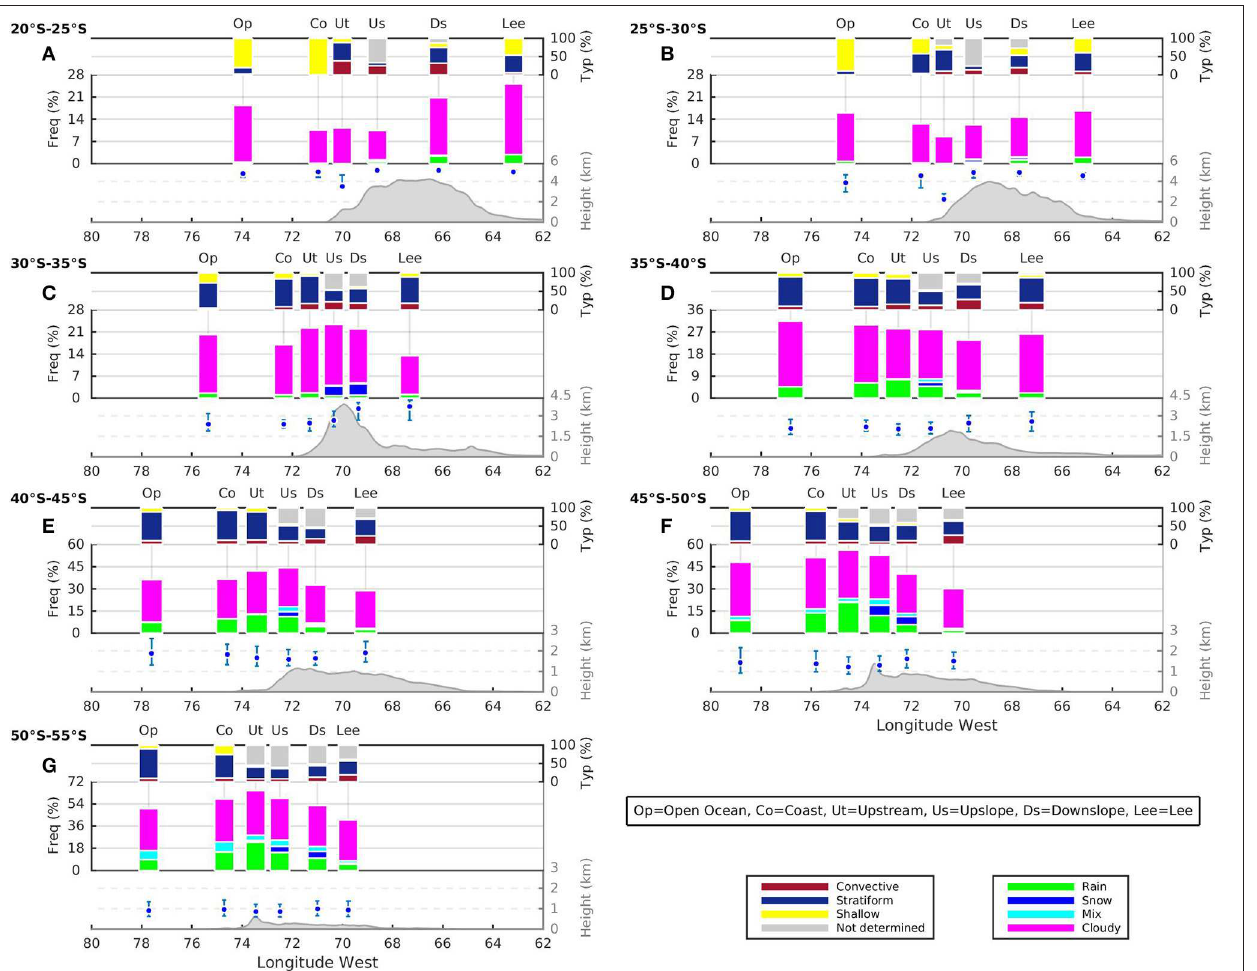
FIGURE 7 | Frequencies (%) of precipitation type (top panels) and precipitating profiles (middle panels), and the elevation of the freezing level (median and interquartile values) in precipitating profiles observed by the CloudSat satellite over the 2006–2016 period in different cross-barrier zones (open ocean, coast, upstream, upslope, downslope, and lee) and for different latitudinal bands: (A) 20–25 ◦ S, (B) 25–30 ◦ S, (C) 30–35 ◦ S, (D) 35–40 ◦ S, (E) 40–45 ◦ S, (F) 45–50 ◦ S, (G) 50–55 ◦ S. The mean cross-barrier altitude of the Andes is plotted in each transect for reference. Note that the y-axis changes the scale in different panels to highlight variations in cross-barrier directions. CloudSat 2C-PRECIP-COLUMN product is used which discriminate between snow, liquid, and mixed phases of precipitating profile, as well as between different type of precipitation (convective, stratiform, and